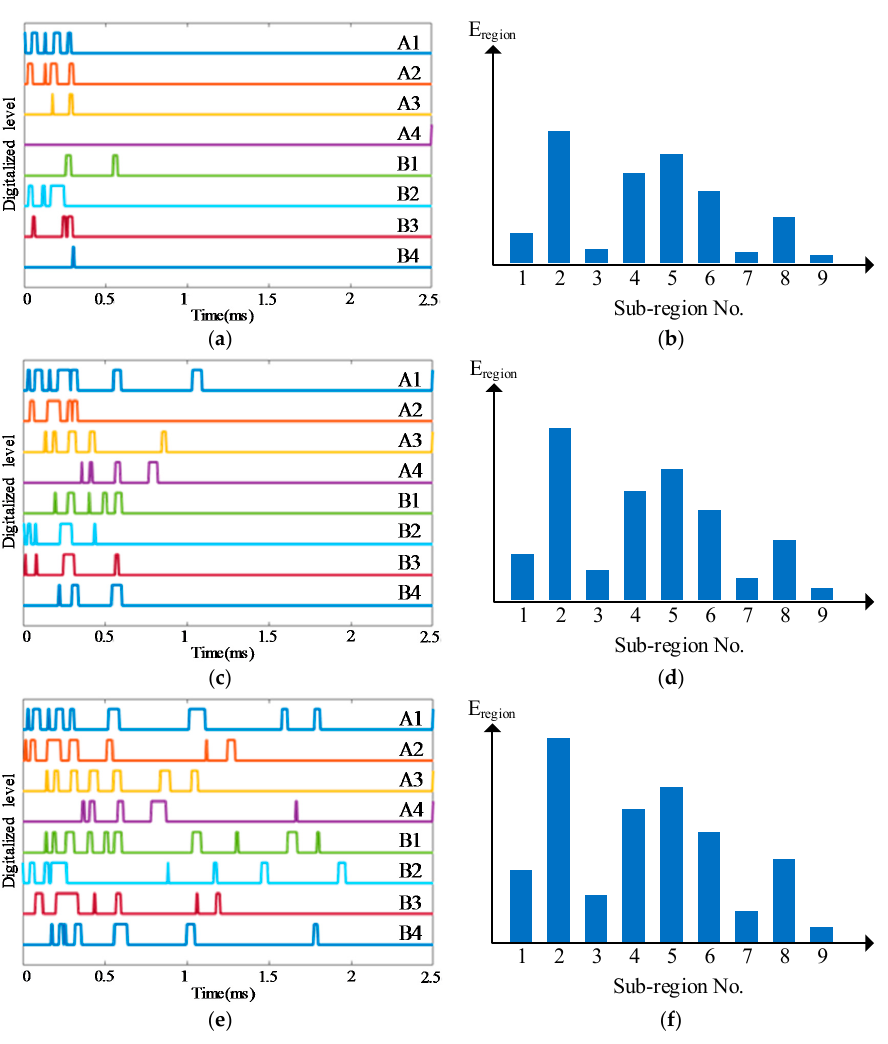
Figure 20. Typical impact region monitoring results on the glass fiber laminate plate based on CPSN under different energy levels: ( a ) CDSs and ( b ) E region of all sub-regions under energy level 1; ( c ) CDSs and ( d ) E region of all sub-regions under energy level 2; ( e ) CDSs and ( f ) E region of all sub-regions under energy level 3.